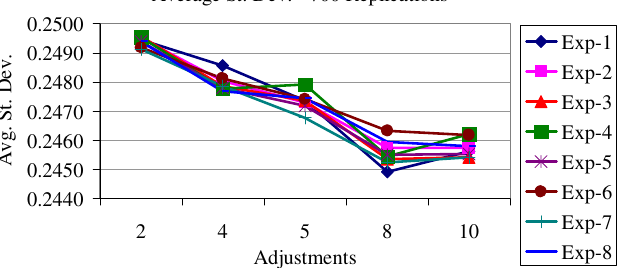
Fig. 4. Average mean and average standard deviation.